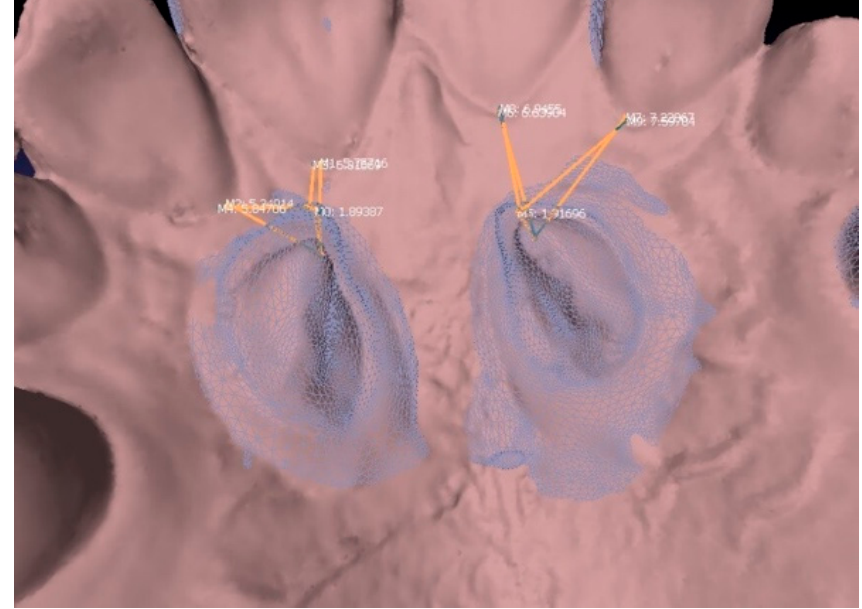
Figure 4. Measurement of the eruption between 2 and 4 months and the distance to the gingival margin of the incisor.